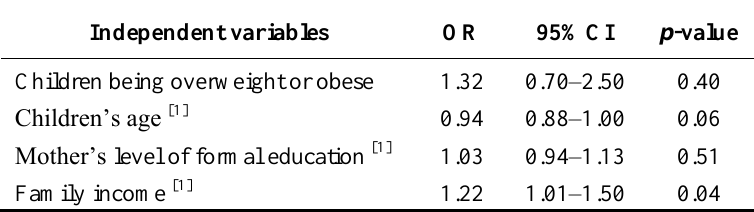
Table 3. Results showing the predictors of having caries